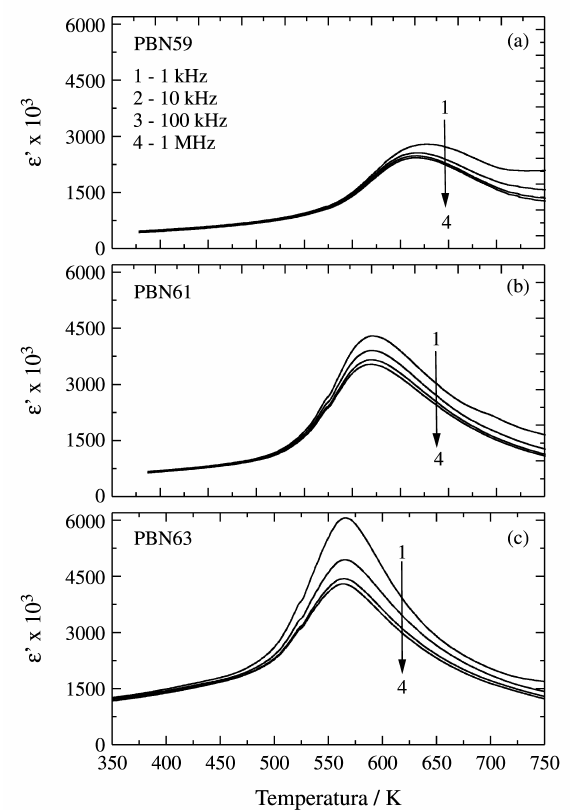
Figura 3. Constante dielétrica em função da temperatura e freqüência para as cerâmicas (a) Pb 0,59 Ba 0,41 Nb 2 O 6 ; (b) Pb 0,61 Ba 0,39 Nb 2 O 6 e (c) Pb 0,63 Ba 0,37 Nb 2 O 6